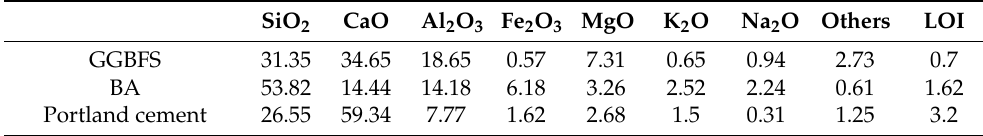
Table 1. Chemical composition of raw material (%).